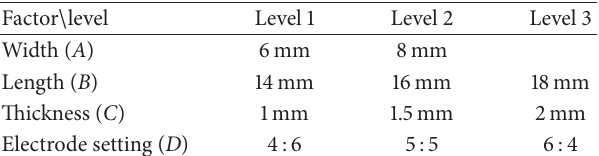
Table 1: The control factors and levels table.